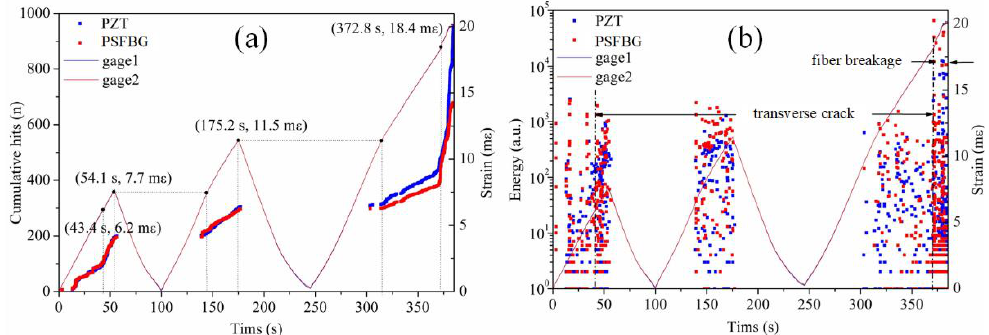
Figure 14. The statistical analyses of the detected AE signals. ( a ) Cumulative AE hits; ( b ) energy distribution.